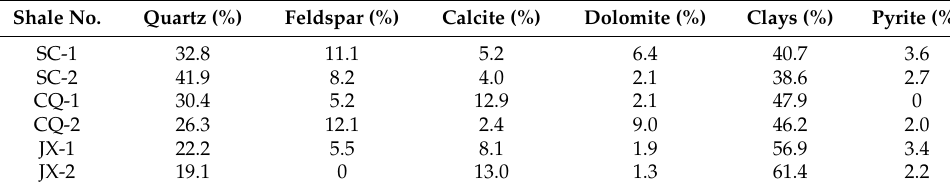
Table A1. Mineral composition of the shale samples from XRD analysis. Shale No.